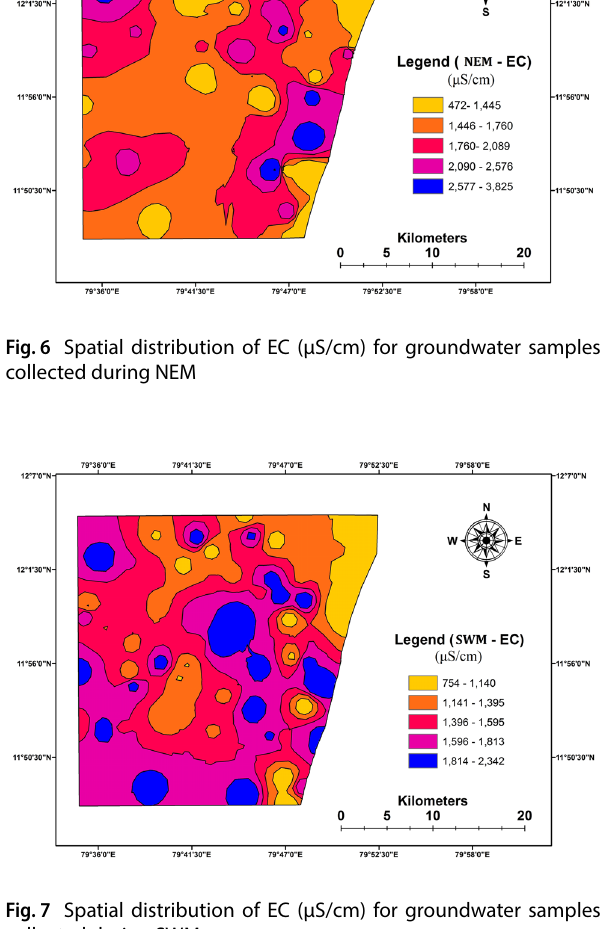
Fig. 7 Spatial distribution of EC (µS/cm) for groundwater samples collected during SWM